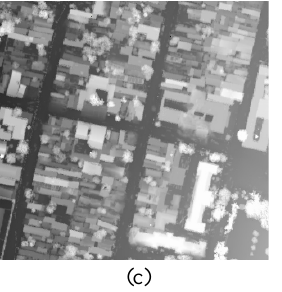
Figure 4: snapshots of (a) before , (b) after , (c) DSM of the area used in this